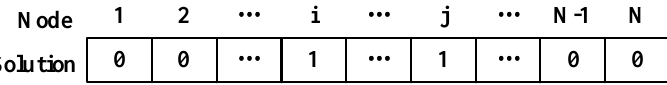
Figure 4. Coding scheme for distributed genetic algorithm and simulated annealing.